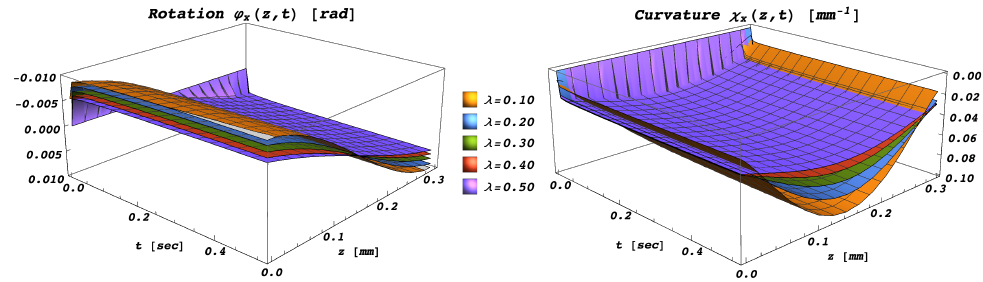
Figure 4. Rotation and curvature for different values of λ .